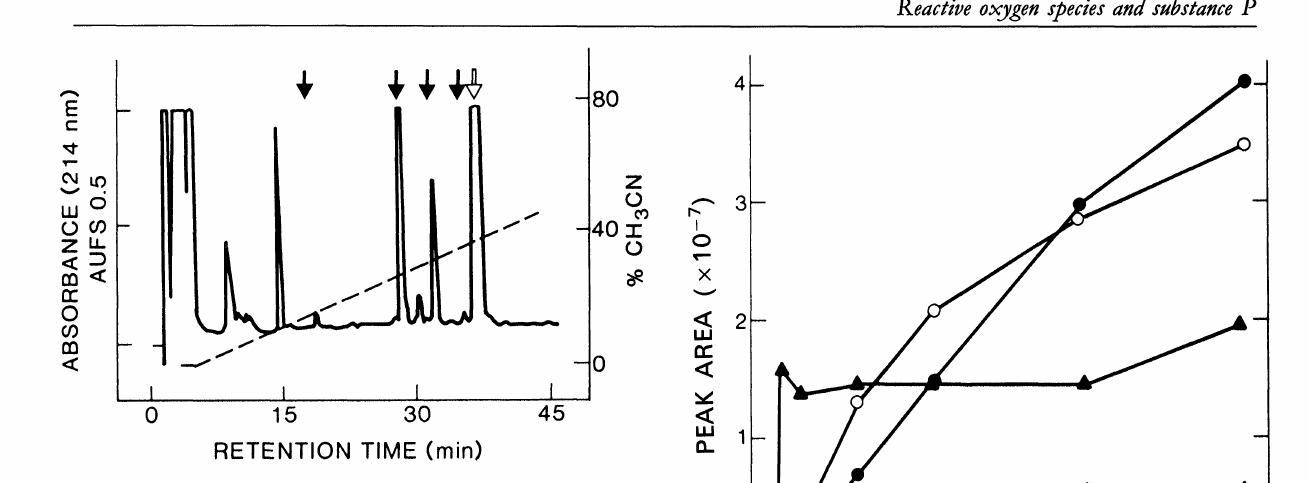
FIG. 1. HPLC chromatogram of substance P1-11 exposed to hydroxyl radical for 2 h. Synthetic substance P (1 mg/ml) in RPMI-1640 was under continuous stirring incubated at +22C in the presence of an excess of hypoxanthine, 85 mU xanthine oxidase, 50/M FeCI3" H20 and 50 #M EDTA. A 100#1 aliquot was recovered and the reaction was stopped by adding superoxide dismutase and catalase to a /g/ml final concentration. A 50 #1 aliquot was then run over a linear 60 min 0-48% ml/min CH3CN gradient with 50 mM NaH2PO4/H3PO 4, pH 3.0, as a buffer and 60% CH3CN in buffer as eluent. The white arrow shows the native substance P1_1 (retention time 36.38 min) and black arrows show the major oxidation products (peaks with retention times 31.95 min corresponding to SP8- and 28.01 min corresponding to SP1-7) and minor oxidation products (peaks with retention times 18.33 min cor- responding to SP9-1 and 35.78 min corresponding to SP-8). All other peaks represent components of the incubation medium or constant injection artefacts, which did not change over time.